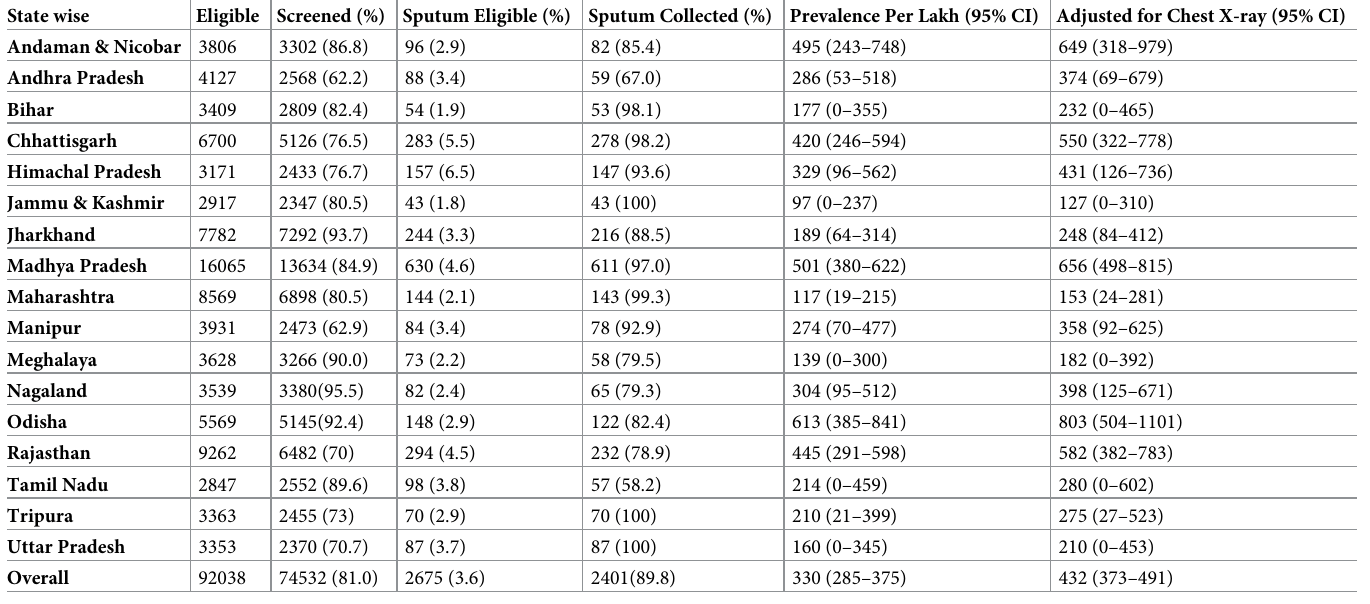
Table 2. Prevalence of smear and/or culture positive pulmonary tuberculosis by state wise (per 100,000 populations). State